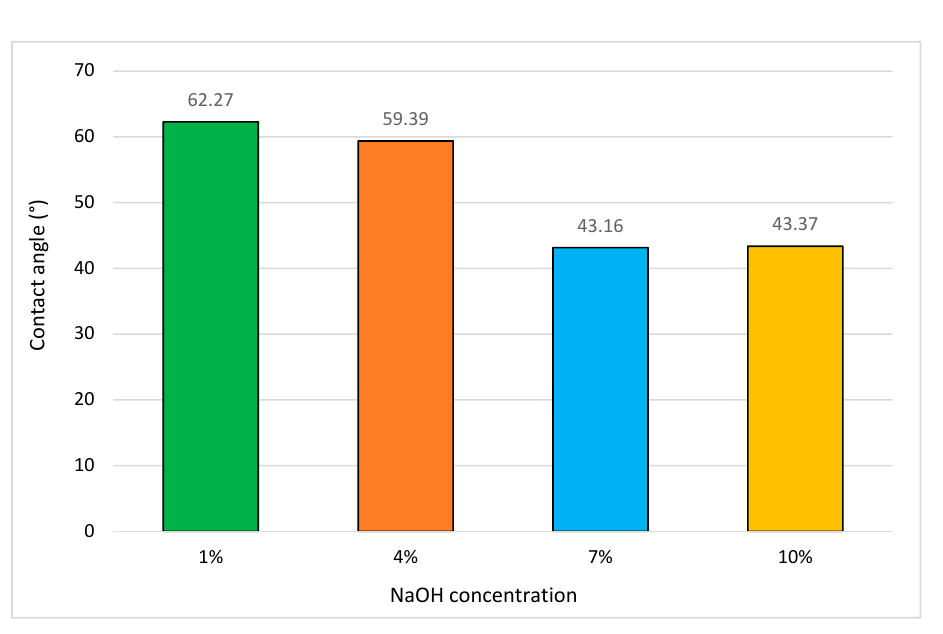
Figure 14. Contact angles of treated rubber crumbs.